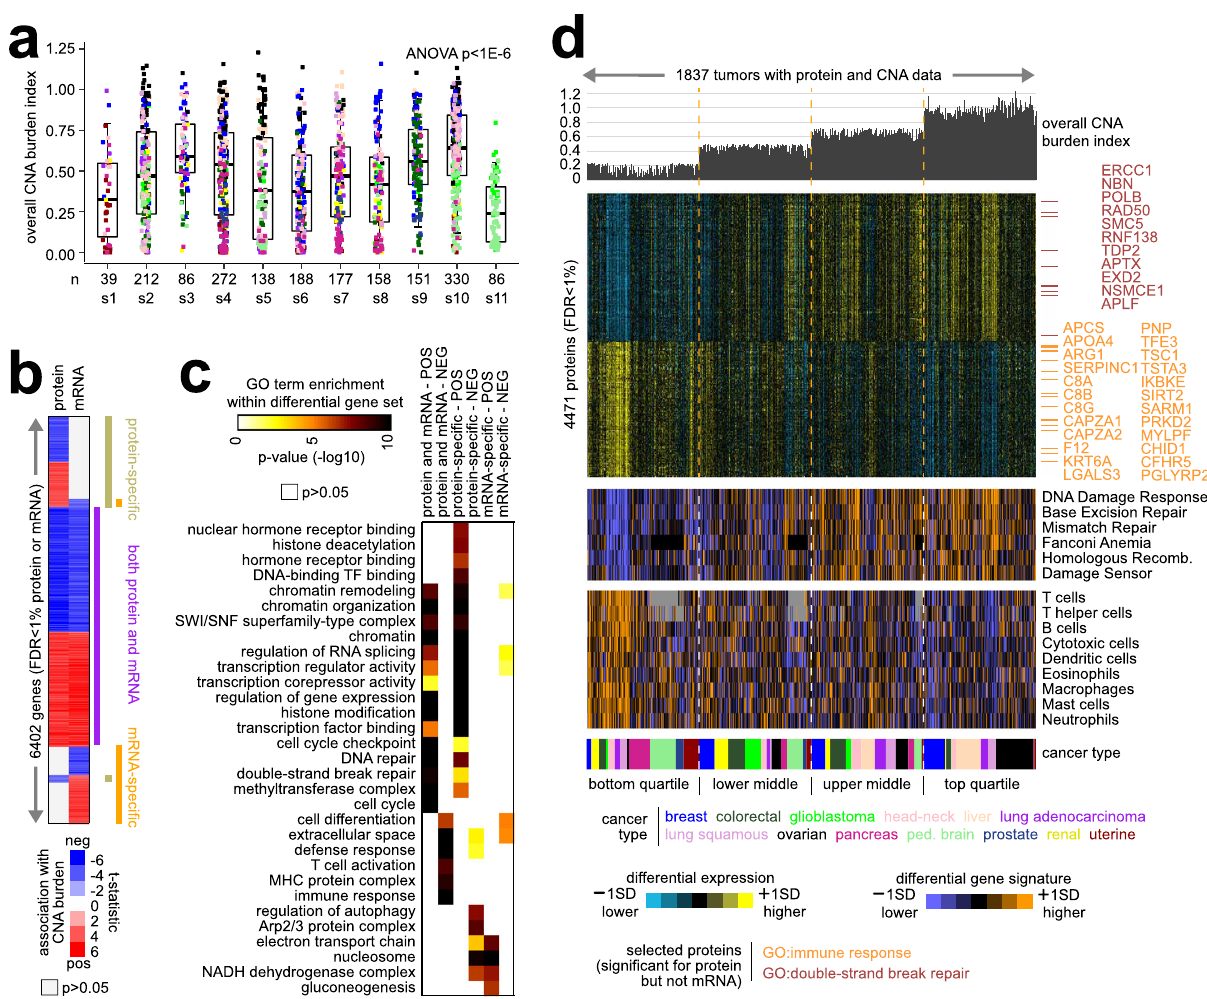
Fig. 6 Global proteomic alterations associated with the overall CNA burden across cancers. a Overall CNA burden index (standard deviation of CNA values across all genes) by proteome-based molecular subtype. Box plots represent 5% (lower whisker), 25% (lower box), 50% (median), 75% (upper box), and 95% (upper whisker). n = biologically independent tumors. p value by ANOVA. Data points are colored according to cancer type (legend in d ). b Protein and mRNA features correlated with CNA burden index (FDR < 1%) across all cancers studied ( n = 1837 tumors with protein and CNA data; n = 1748 with RNA and CNA data), including genes with associations by protein but not mRNA ( “ protein-speci fi c ” ), genes with associations by mRNA but not protein ( “ mRNA-speci fi c ” ), and genes with associations by both protein and mRNA ( “ both protein and mRNA ” ). c For the protein and mRNA signature from b , represented categories by GO were assessed, with selected enriched categories represented here. p values by one-sided Fisher ’ s exact test. d Across the 1837 tumors with protein and CNA data, with tumors ranked high to low by global CNA index quartiles, selected molecular features are represented, including top protein correlates with CNA burden, proteome-based signatures scoring for DNA damage response pathways 52 , and proteome- based scoring for immune cell in fi ltrates 67 . Proteins highlighted by name have GO annotation “ double-strand break repair ” or “ immune response ” and were signi fi cant for protein but not